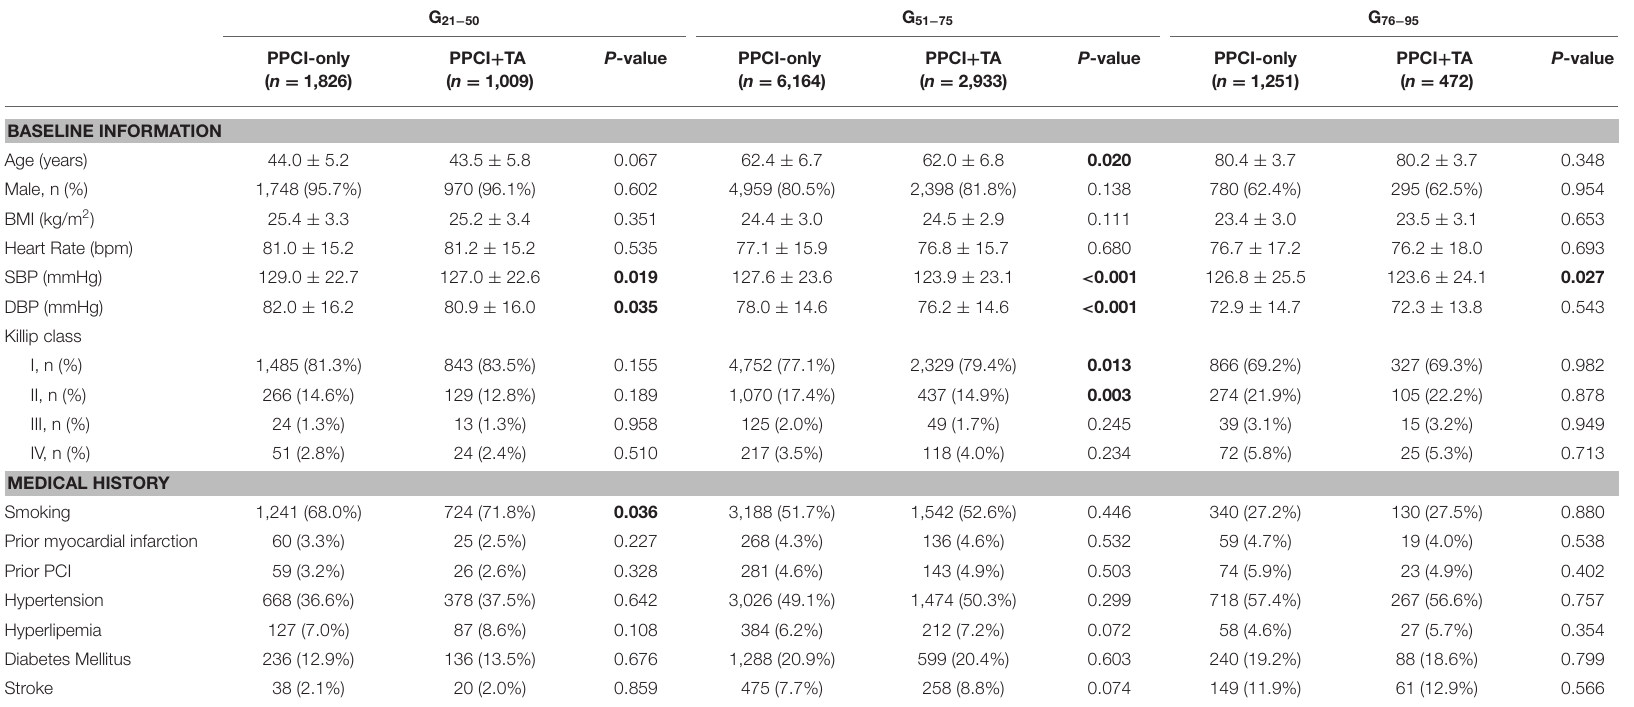
TABLE 1 | The baseline characteristics of the patients ( n =